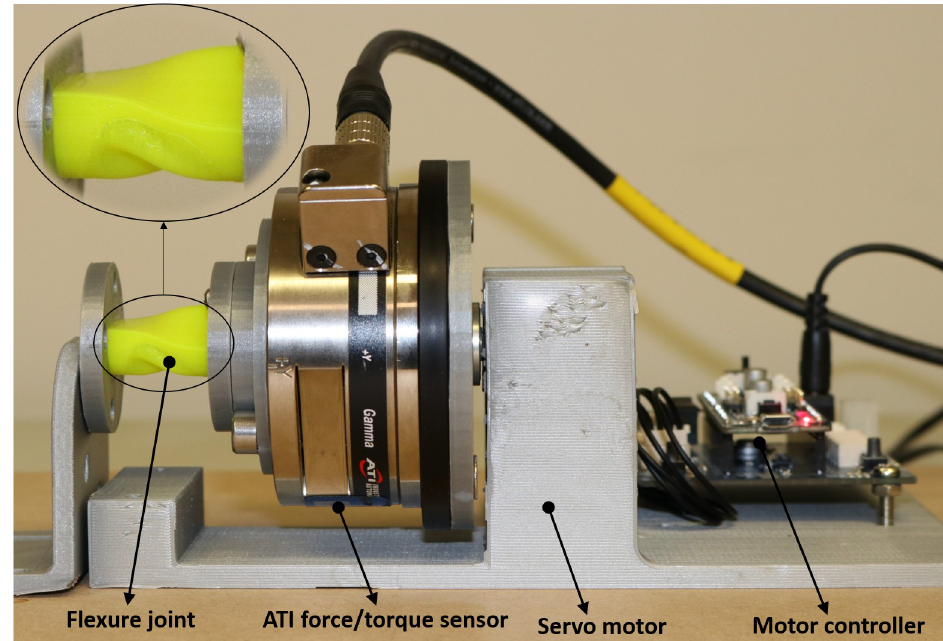
Fig 9. Experimental setup for measuring torsional